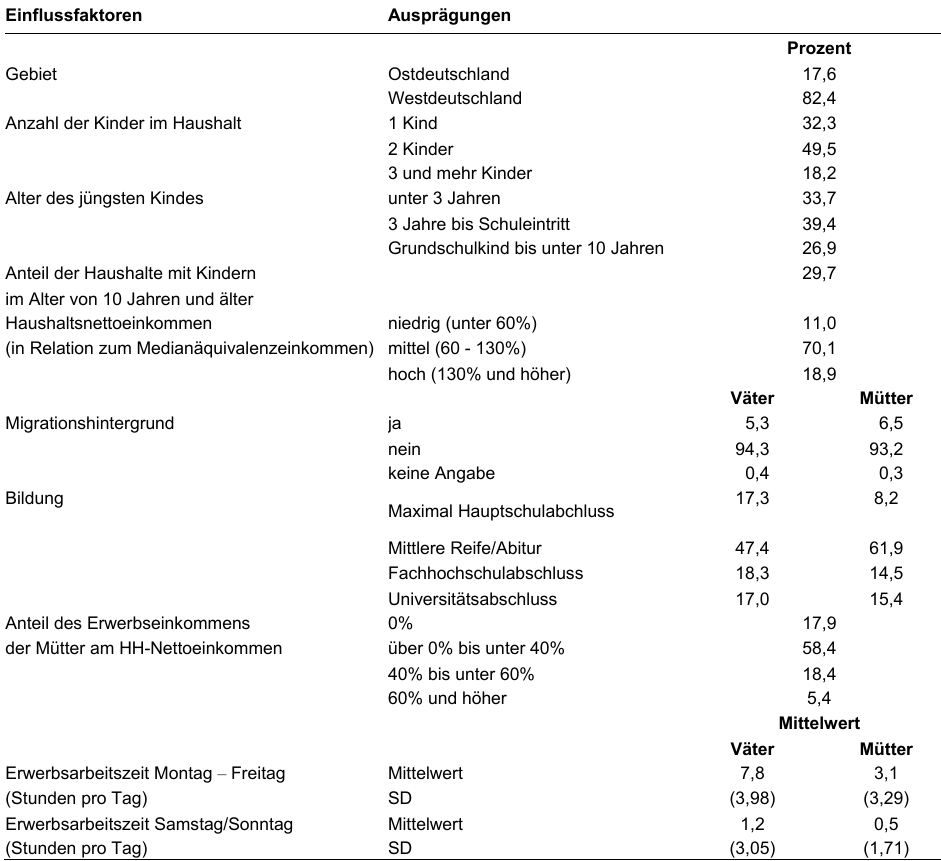
Tabelle 1 : Verteilung der einbezogenen